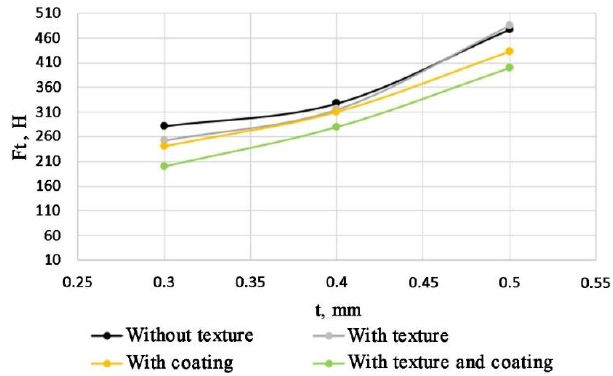
Figure 10. The tangential component of the cutting force on the cutting depth dependence for various tools at a cutting speed of V = 17 m/min and S = 0.125 mm/rev.